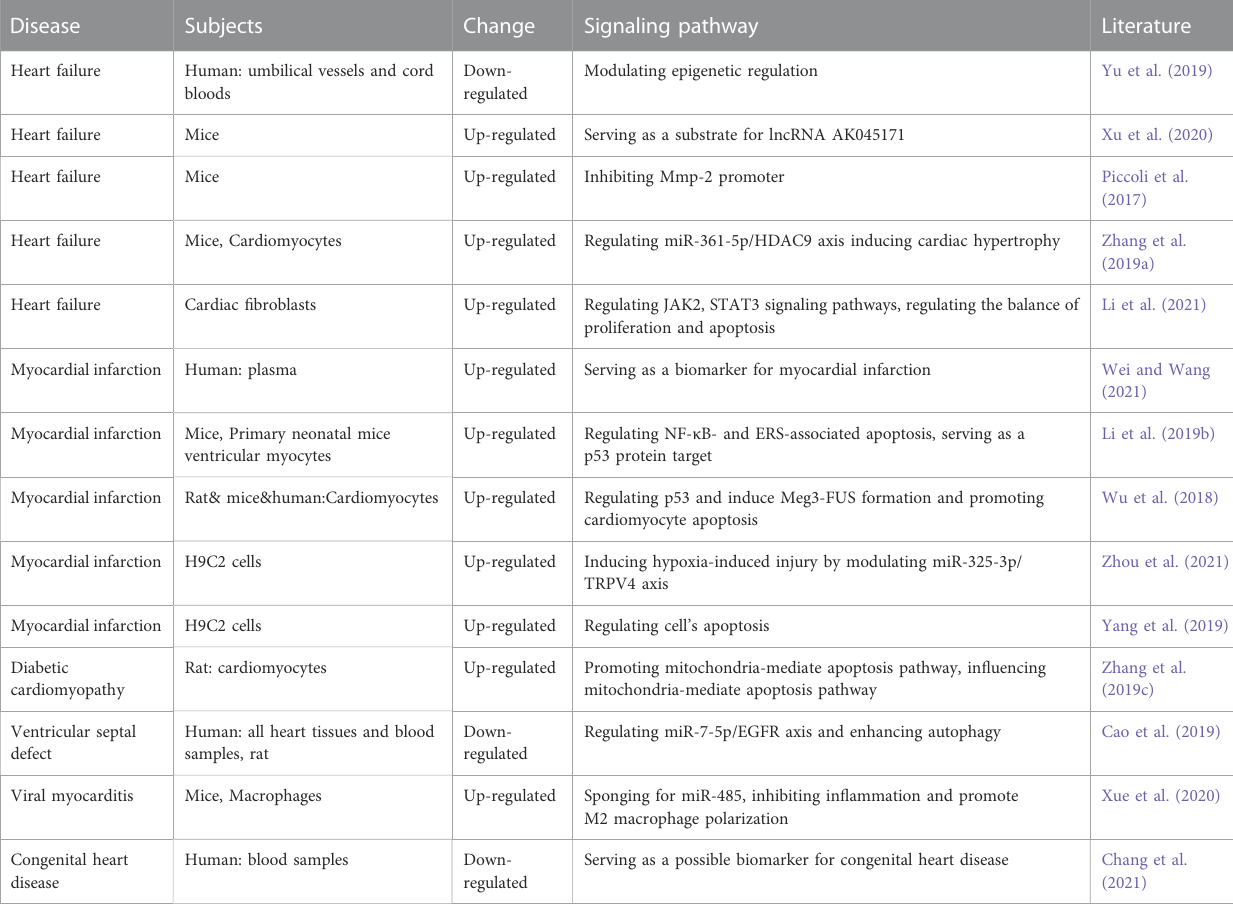
TABLE 1 Roles of lncR-Meg3 in different cardiovascular diseases.